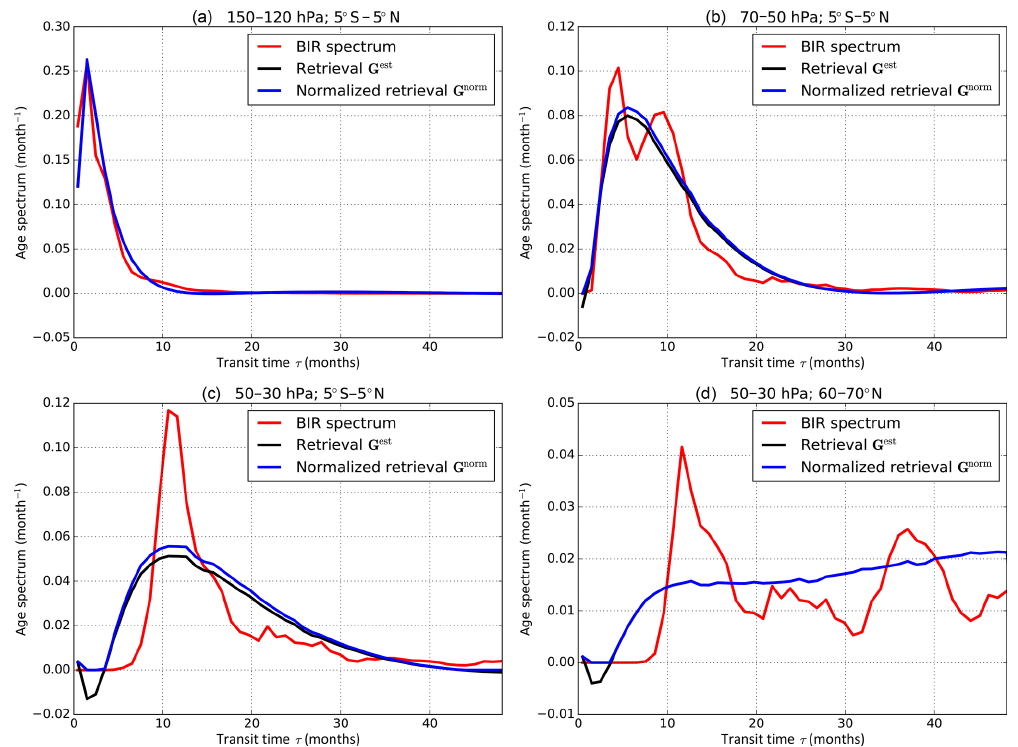
Figure 5. Age spectra retrieved from artificial decaying radioactive tracers, with (blue) and without (black) renormalization, versus spectra estimated using the BIR method (red). The spectra on the different panels correspond to the same CLaMS model simulation on 31 Decem- ber 1983, in different altitude–latitude regions (equatorial upper troposphere a , equatorial lower stratosphere b , equatorial middle stratosphere c , midlatitude middle stratosphere d ). The resolution along the transit time axis is 1 month (the transit times retrieved a span of 0 to 4 years) 2 σ 2 (cid:39) 6500 ( m 3 m − 3 ) 2 h 2 (cid:15) and the chosen regularization strength is α σ 2 a